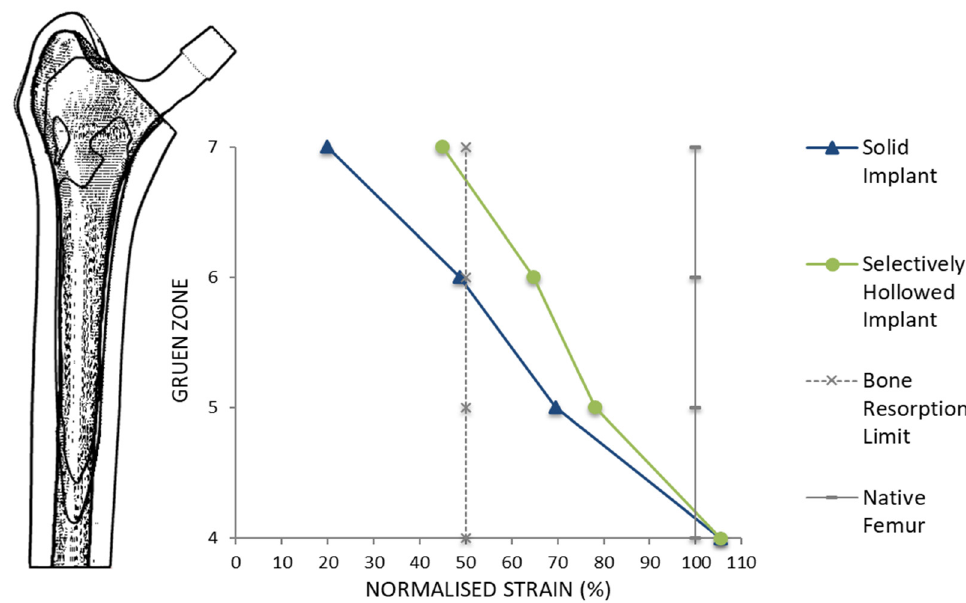
Figure 9. Peri-implant surface bone strain as a percentage of the strain measured for the native femur for different Gruen zones. A typical bone resorption limit of 50% was also indicated. The selectively hollowed implant strain shielded the femur less than the solid implant.